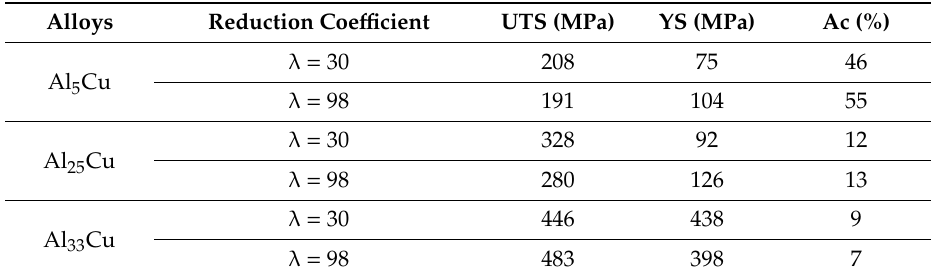
Table 1. Measured mechanical parameters: yield strength (YS), ultimate tensile strength (UTS), and elongation to fracture (Ac) of deformed Al–Cu alloys with KoBo processing.